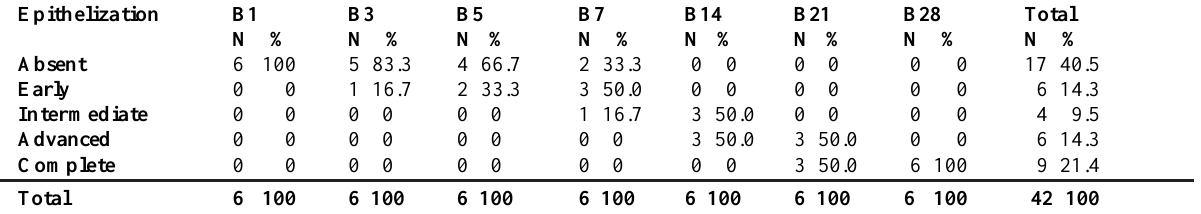
TABLE 3 - Distribution of animals according to the epithelization status of the duodenal wound repair region in Group B